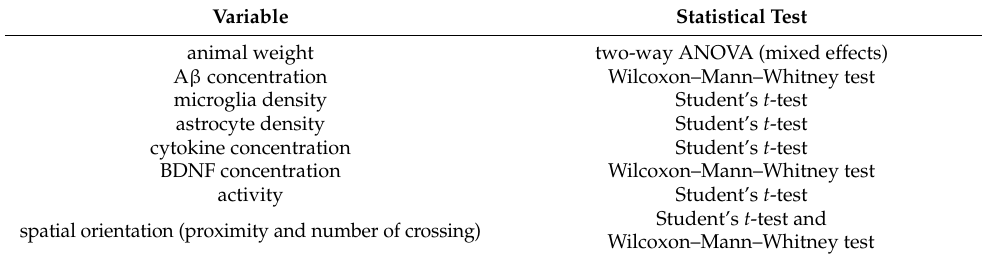
Table A2. Statistical tests used for the evaluation of differences between experimental groups for each variable